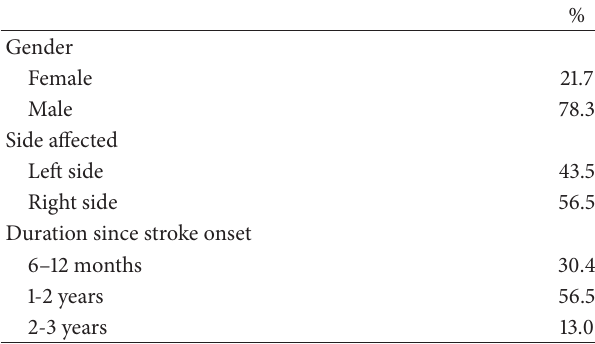
Table 1: Descriptive statistics.